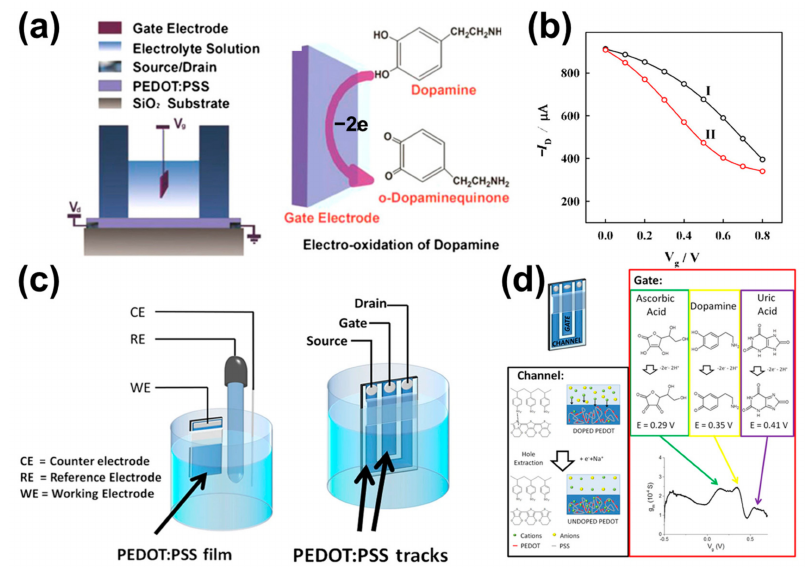
Figure 5. ( a ) To detect levels of dopamine in the sweat of biosensor based on OECT schematic diagram. ( b ) Typical output curve of OECT. (The black line I is blank and the red line II is dopamine.) ( c ) Experiments were conducted in the apparatus of an amperometric cell with 3 electrodes and OECT, respectively. ( d ) The selective principle of OECT PEDOT:PSS. ( a ) Reproduced with permission